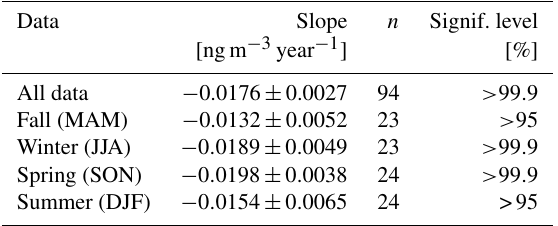
Table 2. Least-squares fit of monthly median of all GEM concen- trations for September 1995–December 2004.